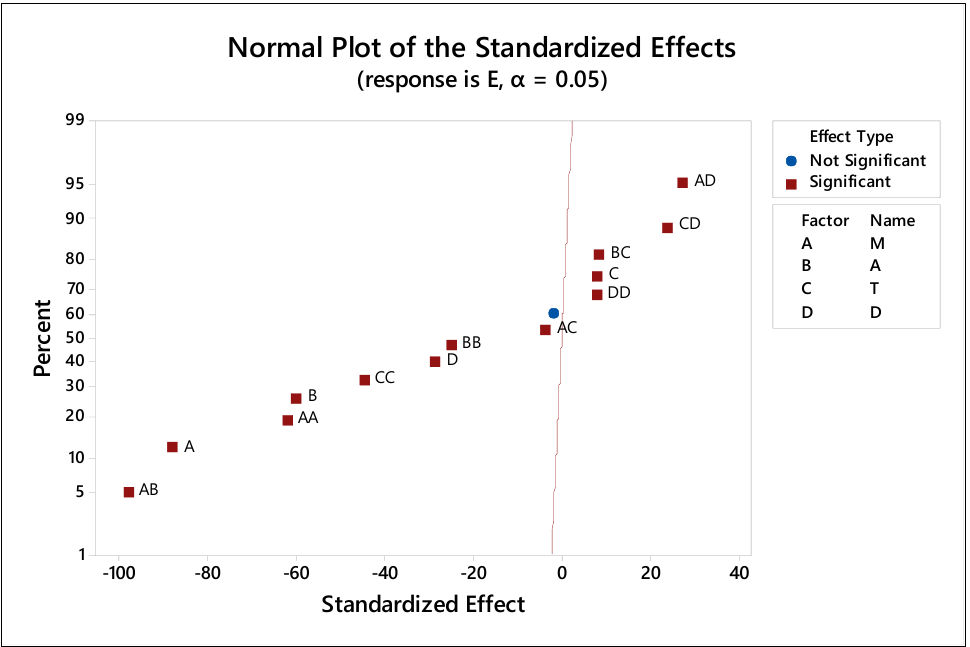
Figure 26. Normalised plot determining the standardised effect of the parameters on the esterification of WCO.